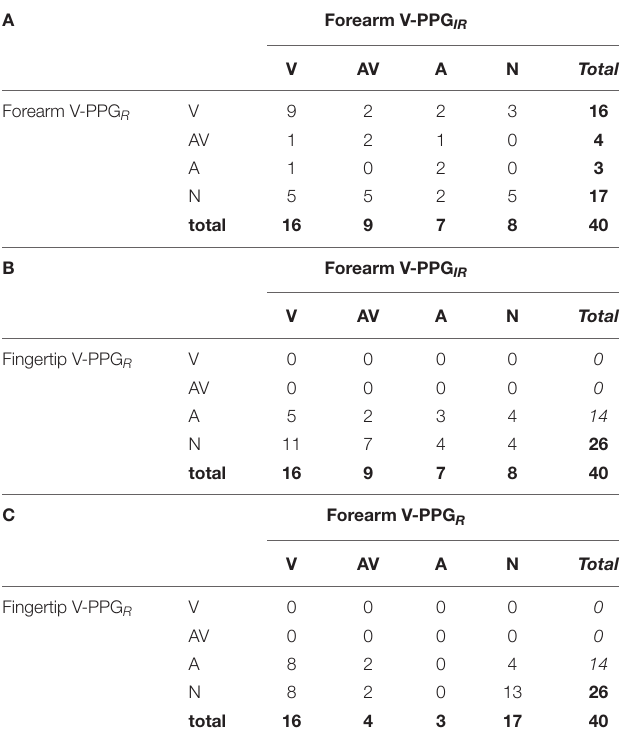
TABLE 2 | Classification of the patterns observed with red (R) or IR venous photoplethysmography (V-PPG) for each studied limb ( n = 40). A Forearm V-PPG IR